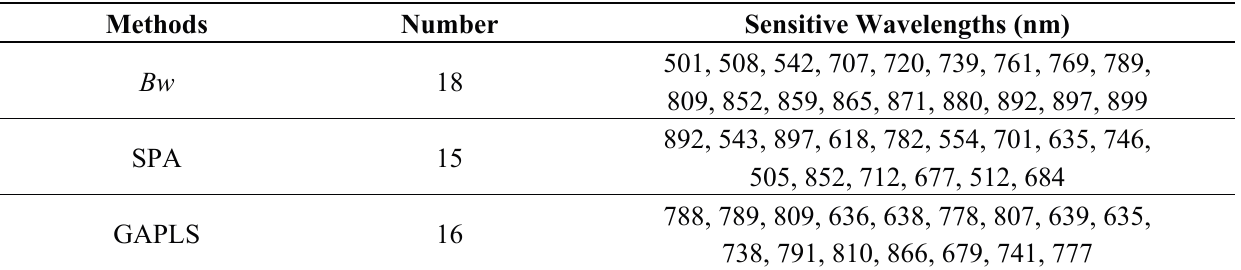
Table 2. The selected sensitive wavelengths by weighted regression coefficients ( Bw ), SPA and